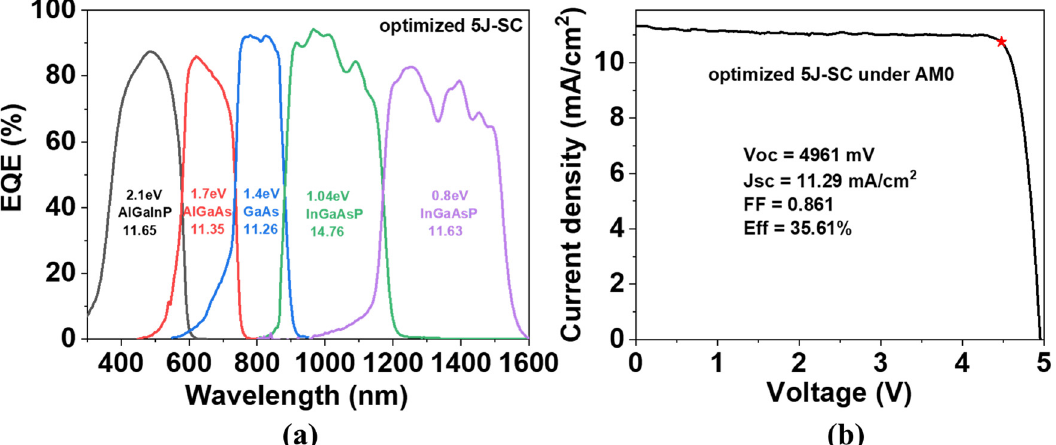
Figure 9. EQE curve ( a ) and light J–V curve ( b ) of SBT 5-junction solar cell. The bandgap combination of optimized SBT-5J solar cell is 2.1 eV, 1.7 eV, 1.4 eV, 1.04 eV and 0.8 eV, which is made of AlGaInP, AlGaAs, GaAs, InGaAsP and InGaAsP sub-cell, respectively. Light J–V curve is measured under AM0 spectrum (AM0, 25 ◦ C) and calibrated by multiple reference